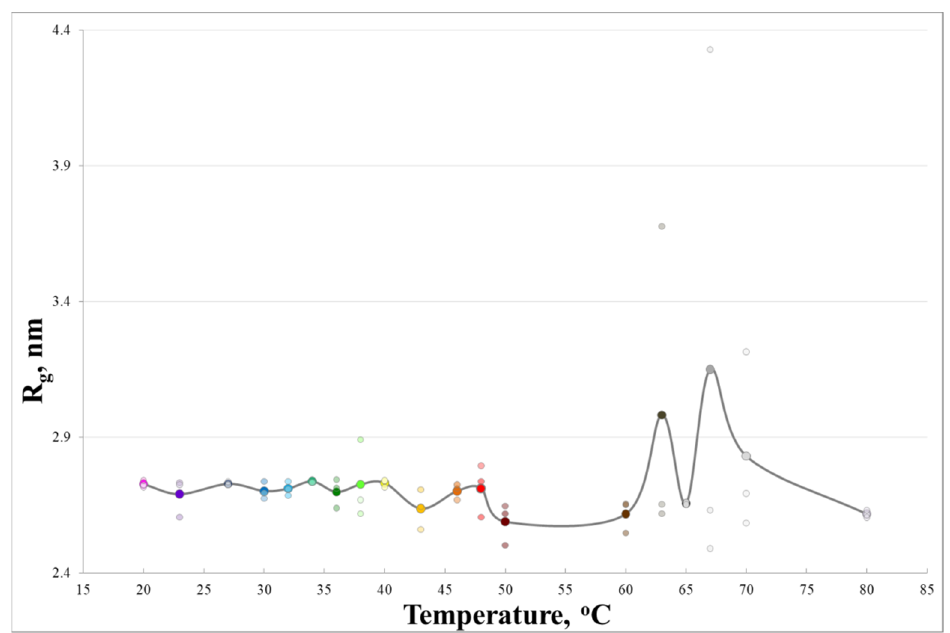
Figure 6. R g of proteinase K dimers averaged over C α atoms at different temperatures (from 20 to 80 °C). Saturated connected points represent data averaged over three independent simulations marked by unsaturated points.